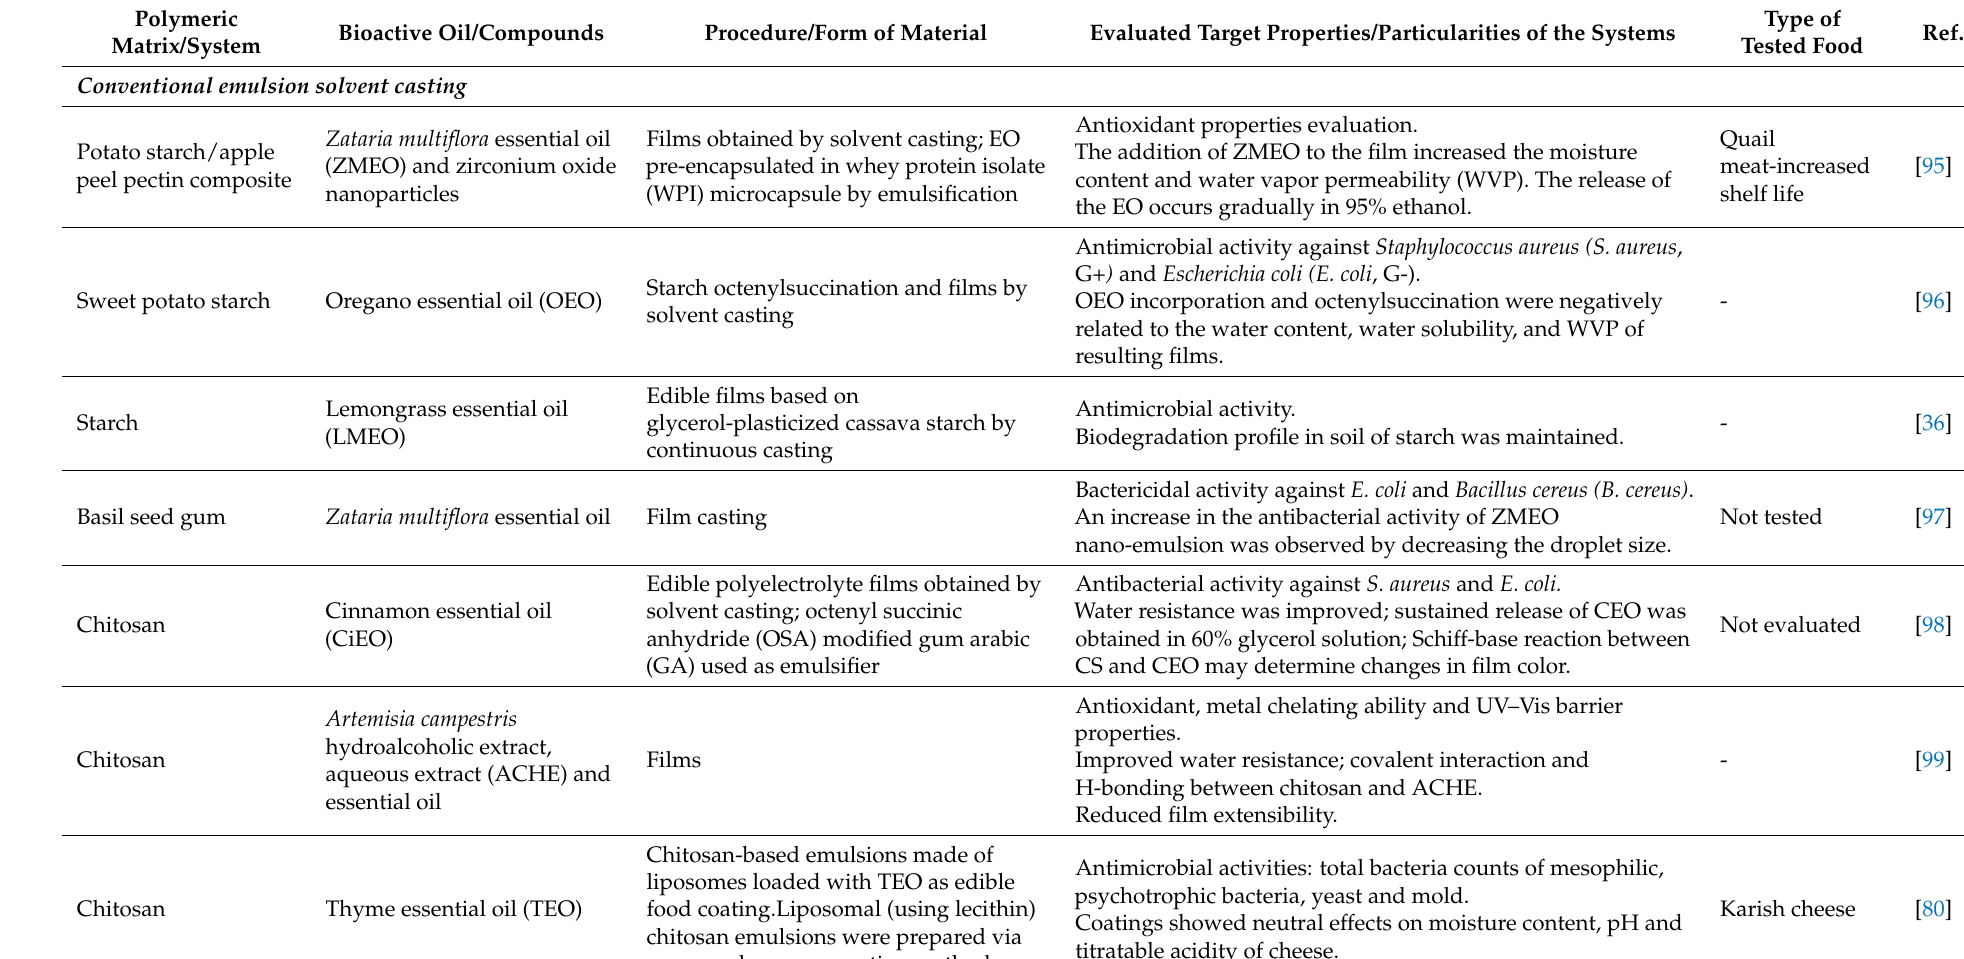
Table 1. Recent examples of essential oils incorporated into biodegradable packaging materials by emulsification